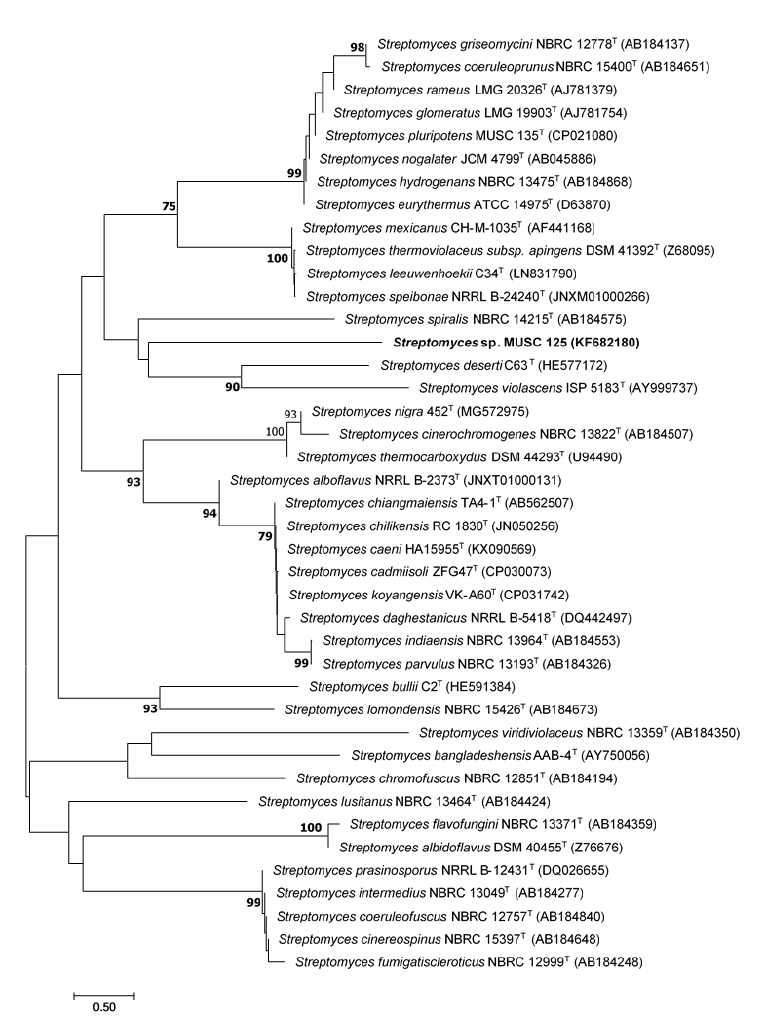
Figure 1. Neighbour-joining phylogenetic tree based on 1491 nucleotides of the 16S rRNA gene sequence showing the relationship between strain MUSC 125 and representatives of related taxa. Numbers and nodes indicate percentages (>50%) of 1000 bootstrap re-sampling. Bar, 0.5 substitutions per site.